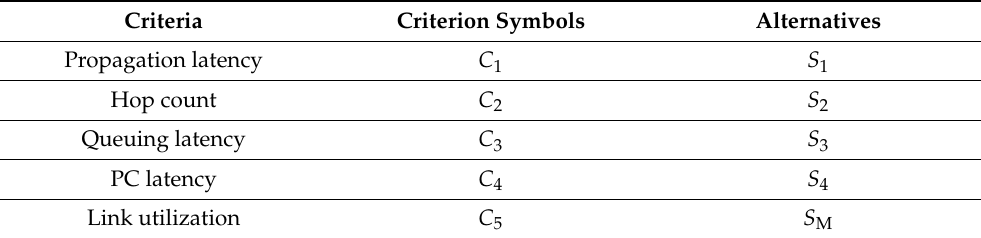
Figure 4. Placement of controllers in OS3E demonstration with ANP model. Table 2. Alternatives and